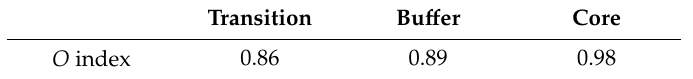
Table 4. The overlap index between mangrove of NDVI and referenced mangrove in 2015.